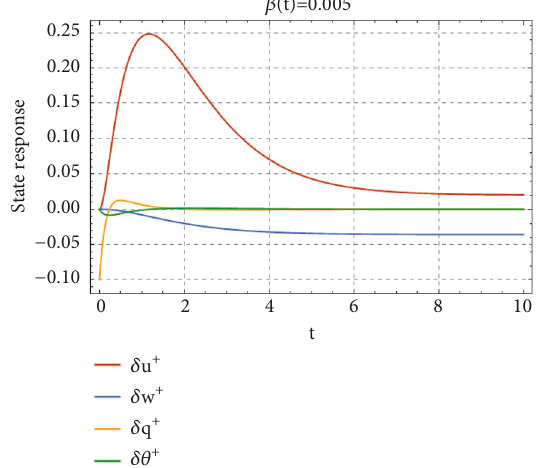
Figure 5: State response of an FMAV with its tail controlled by a